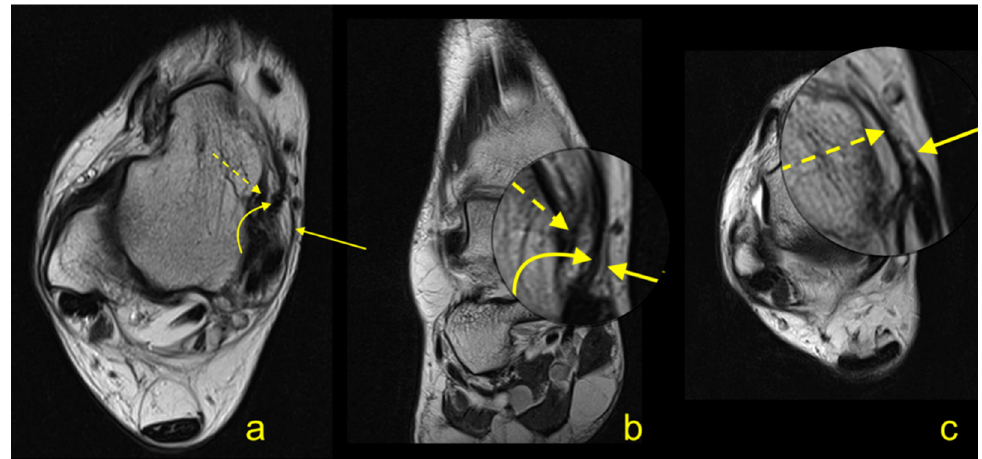
Figure 2. A 43-year-old patient with clinical suspicion of a ganglion. ( a – c )—PD weighted images.